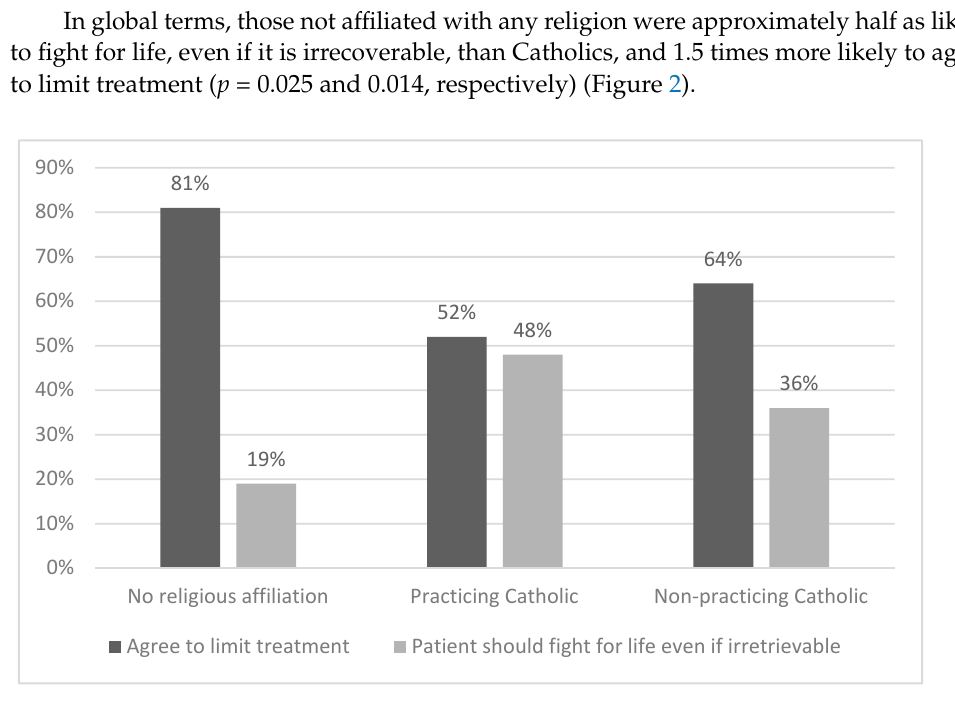
Figure 2. Attitude toward treatment limitation by religious affiliation.